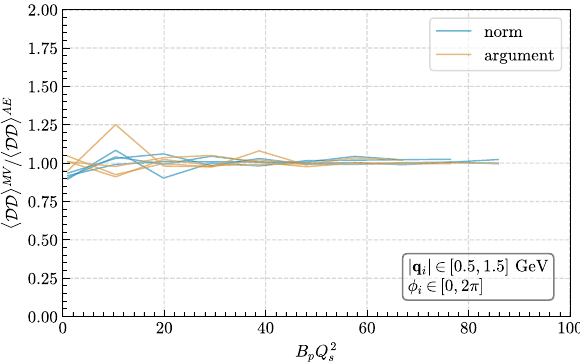
Fig. 9 Ratio of the Fourier transforms of Eqs. (A2) and (A1) at different values of B p . The values of the ratio were computed using four sets of random momenta with moduli between 0.5 and 1.5 GeV. We present both the norm (blue lines) and the argument (yellow lines). We have